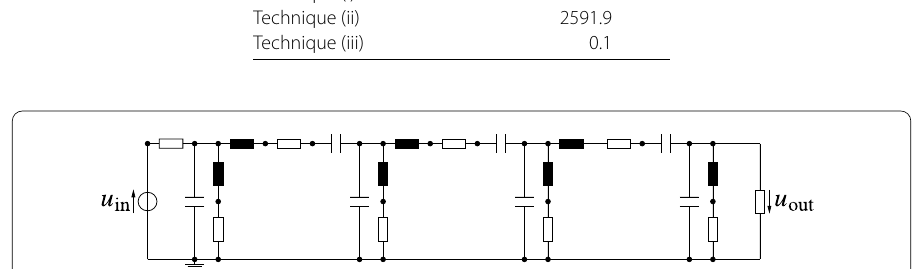
Figure 7 Electric circuit of band-pass filter (white boxes: resistors, black boxes: inductors, parallel lines: capacitors)